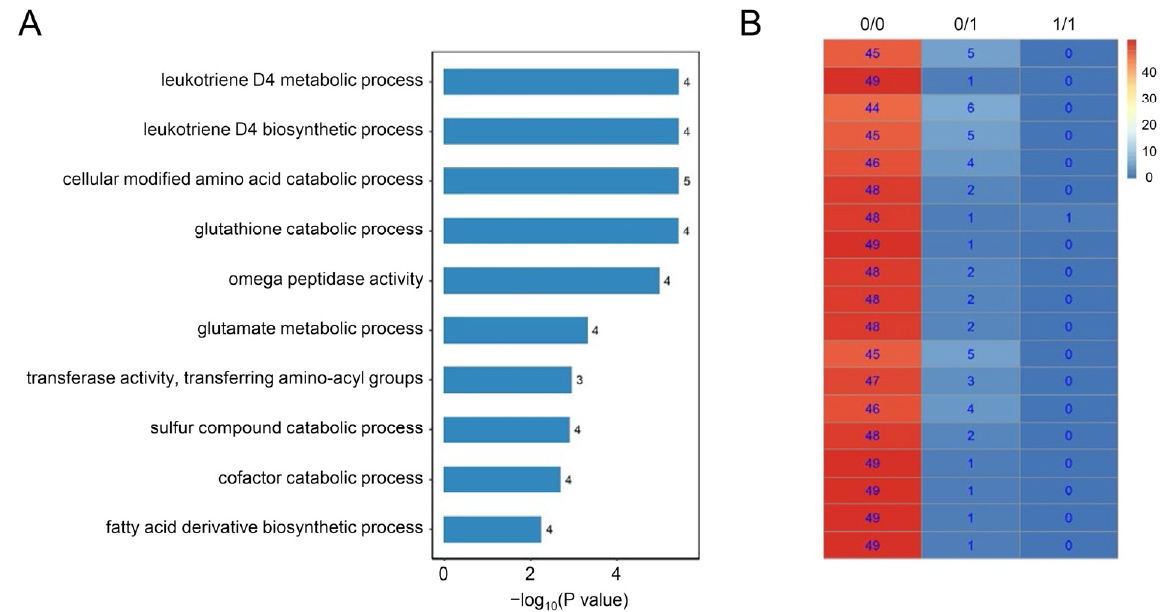
Figure 3. ( A ) GO enrichment analysis of genes harbored 105 LoFs and missense SNPs. ( B ) Distribution of candidate SNPs (SNP-1) in 19 cases. 0/0, homozygote for the reference allele; 0/1, heterozy- gote; 1/1, homozygote for the alternative allele.